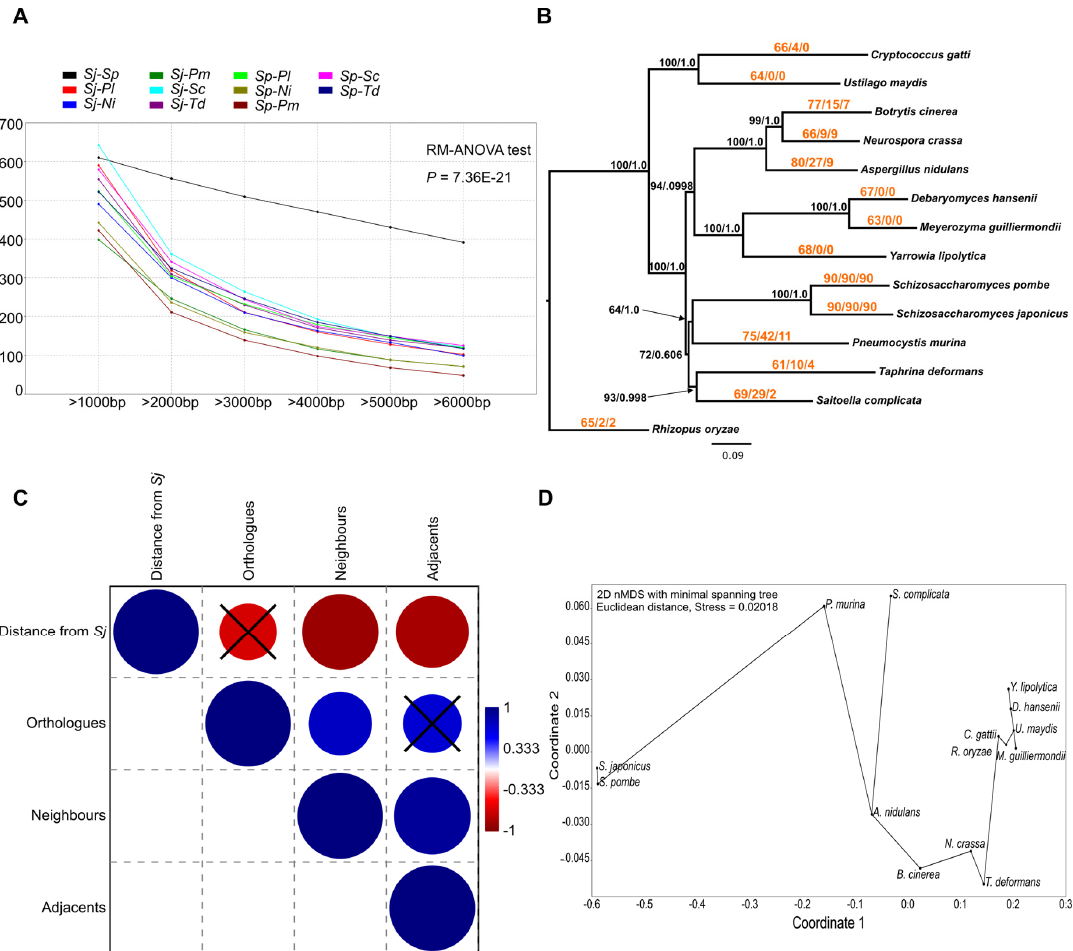
Figure 4. Gene order of the aLCBs is mainly fission-yeast-specific but further supports the idea of filamentous ancestors. ( A ) Frequency graph of the common LCBs among the species pairs in different lengths. The figure shows that none of the Taphrinomycotina species exhibit such high number of common LCBs with the fission yeasts than the S. japonicus - S. pombe species pairs. Abbreviations: Sj- S. japonicus ; Sp- S. pombe ; Pl- P. lactucae-debilis ; Pm- P. murina ; Td- T. deformans ; Sc- S. complicata ; Ni: N. irregularis . ( B ) Phylogenetic tree inferred from 26 common putative orthologous protein sequences from 11 randomly selected aLCBs of the fission yeasts. Colourful numbers on the branches indicate the following data: (number of common orthologues with the Schizosaccharomyces /number of neighbouring genes among the orthologues/number of adjacent genes among the orthologues). Statistical support of the nodes came from NJ bootstrap analyses (100 replicates) and ML aLRT. ( C ) Pairwise Spearman correlations of the concerning data. Blue circles represent positive correlations, reds indicate negative correlations. Phylogenetic distance from S. japonicus and the number of common orthologues, moreover the number of common orthologues and the number of adjacent orthologues were not correlated significantly (black crossed circles). Phylogenetic distance and the found neighbouring genes and adjacent genes were correlated significantly. Bonferroni corrected p values are presented in Supplementary Table S13. ( D ) 2D nMDS with minimal spanning tree computed from the previous data shows that gene order of the fission yeast exhibits more similarity to the filamentous fungi than to the other yeast